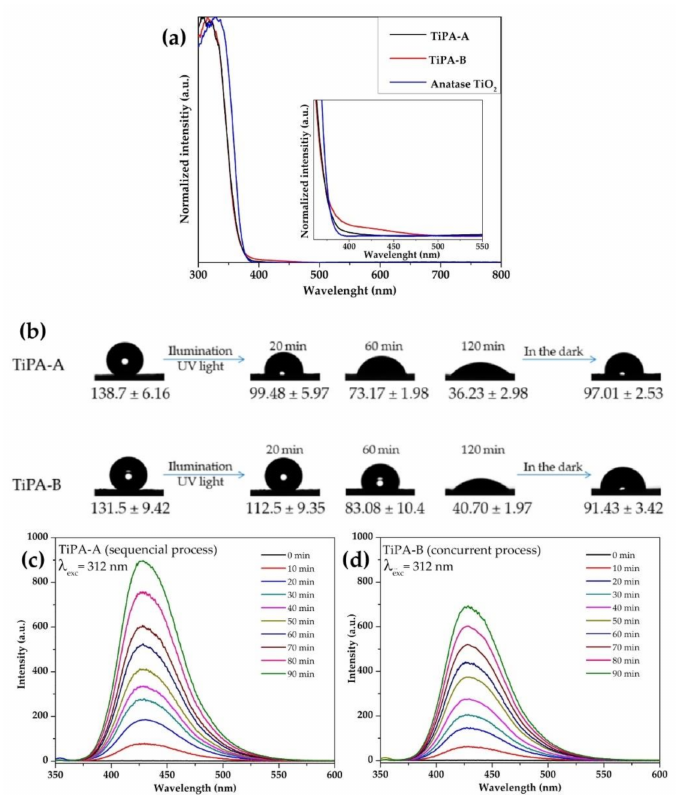
Figure 4. Diffuse reflectance spectra (DRS) of nanocomposites ( a ); contact angle measurements under dark and illumination at 365 nm ( b ); • OH-trapping photoluminescence spectra of TiPA–A and TiPA–B in a solution of terephthalic acid at room temperature ( c ) and ( d ),